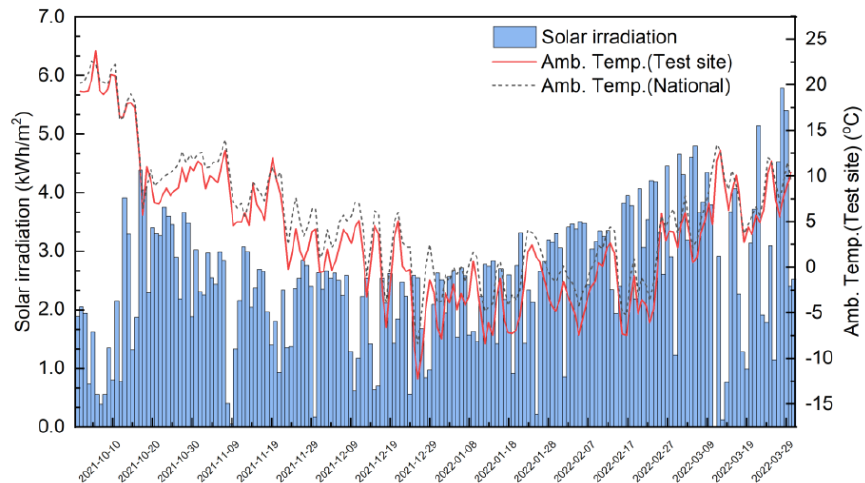
Figure 4. Daily solar irradiation and ambient temperature.